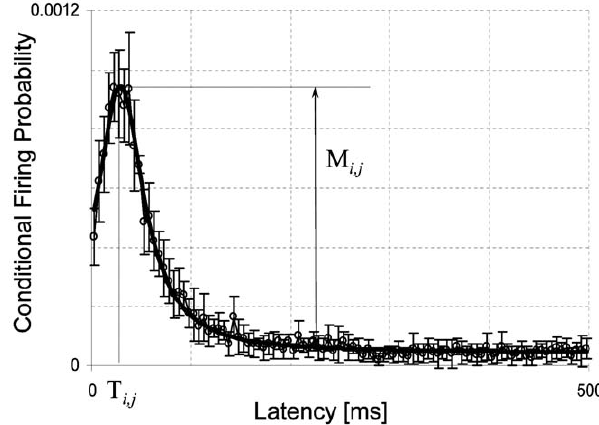
Figure 2. Example of estimated conditional firing probability ( # , mean 6 SD of 5 consecutive bins of 0.5ms each). Solid line represents fitted equation, used to obtain values for strength (M i,j ) and latency (T i,j ) of the functional connection between a pair of electrodes ( i,j ).